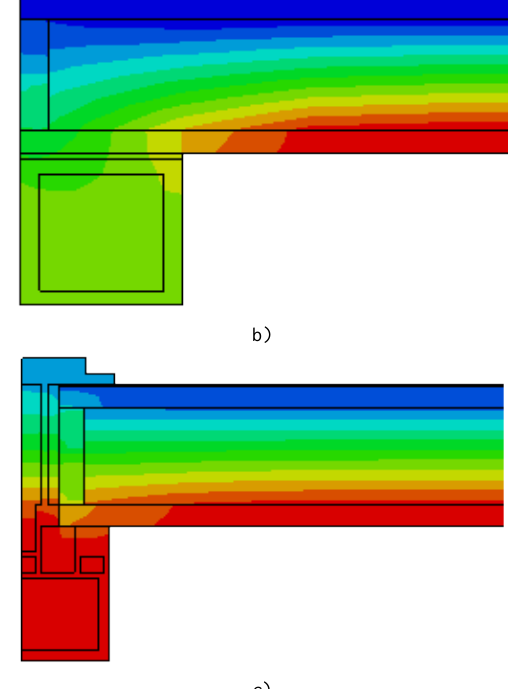
Fig. 8 Cross-sectional detail of temperature distribution (ABAQUS, legend in [°C]), as obtained for the a) GFRP-glass sandwich, b) GFRP-glass layered and c) non-integrated curtain wall with aluminium frame